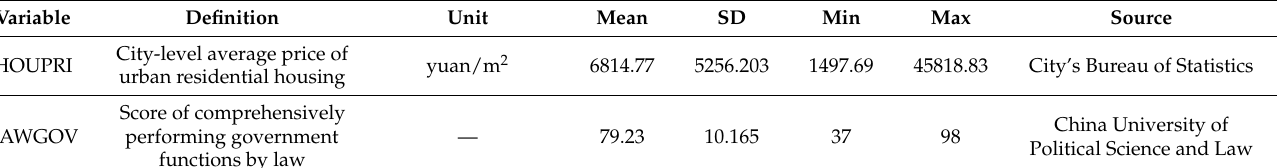
Table 2. Definitions of variables and descriptive